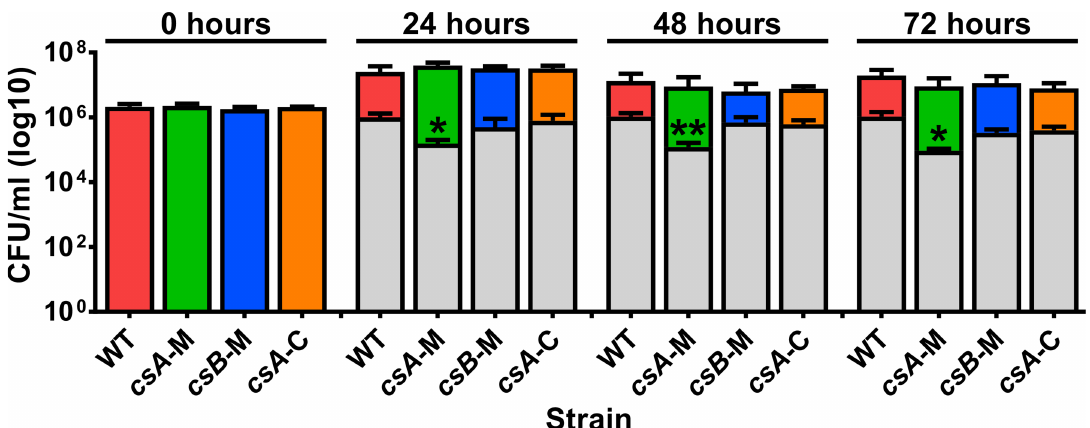
At each time point all strains show similar total cell counts, however the csA mutant produces less spores than the wild-type strain. The results represent the average of four independent experiments and error bars represent standard error of the mean. Asterisks indicate statistical difference in comparison to WT at (cid:3) , p (cid:20) 0.05; (cid:3)(cid:3) , p (cid:20) 0.01. Wild-type, WT; csA mutant, csA -M; csB mutant, csB -M; csA mutant complemented, csA -C.